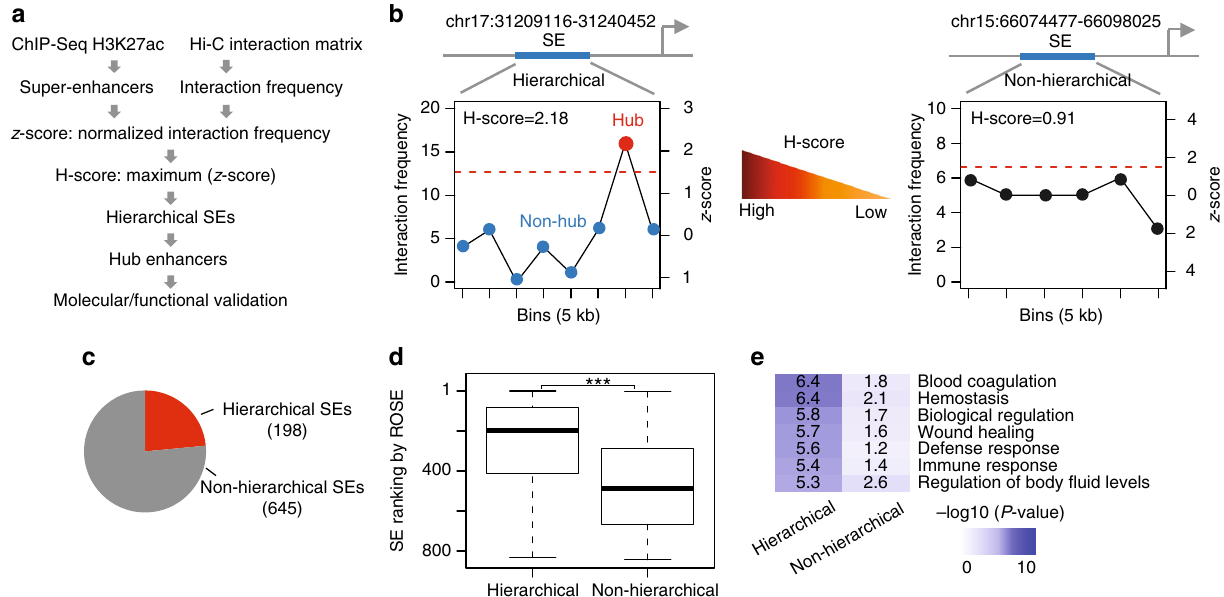
Fig. 1 De fi nition of hierarchical SEs and hub enhancers based on Hi-C chromatin interactions in K562 cells. a Overview of pipeline. b Representative hierarchical (left) and non-hierarchical (right) SEs. For each 5 kb bin within SE, the frequency of chromatin interactions (left y- axis) of and the z -score (right y- axis) is shown. The dashed red line represents the threshold of z -score = 1.5. c The proportion of hierarchical and non-hierarchical SEs. ( d ) The ROSE ranking of hierarchical and non-hierarchical SEs. In box plots, the center line represents the median, the box limits represent the 25th and 75th percentiles and the whiskers represent the 5th and 95th percentiles. P values were calculated using Wilcoxon rank-sum test. *P < 0.05; **P < 0.01; ***P < 0.001. ( e